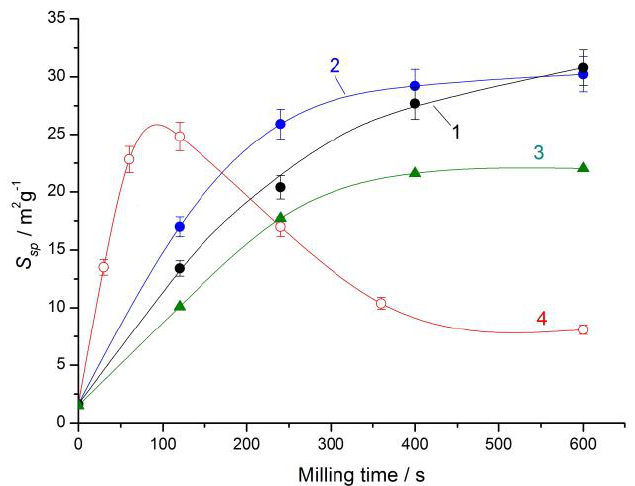
Figure 1. Specific surface areas of antigorite and antigorite-containing ore dressing tailings (AT) as a function of milling time. Curves 1 and 2 : moderate mechanical activation (MA) of antigorite in air and CO 2 , respectively; 3 : moderate MA of AT in air; 4 : hard MA of antigorite in air.